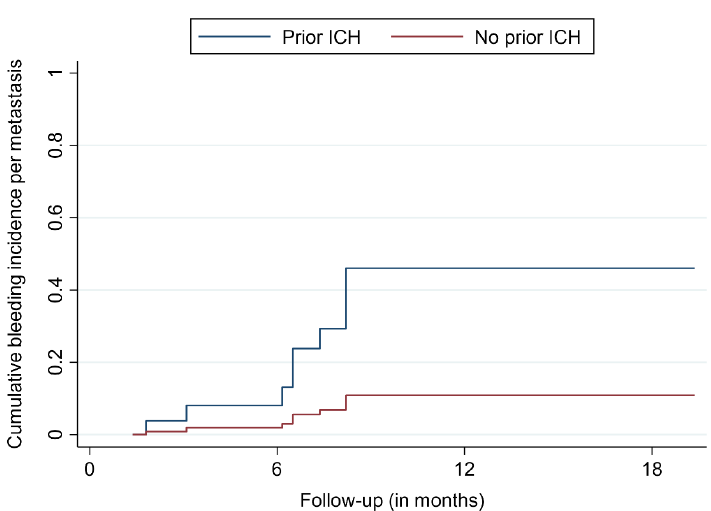
Figure 3. Cumulative incidence of bleeding events per metastasis.